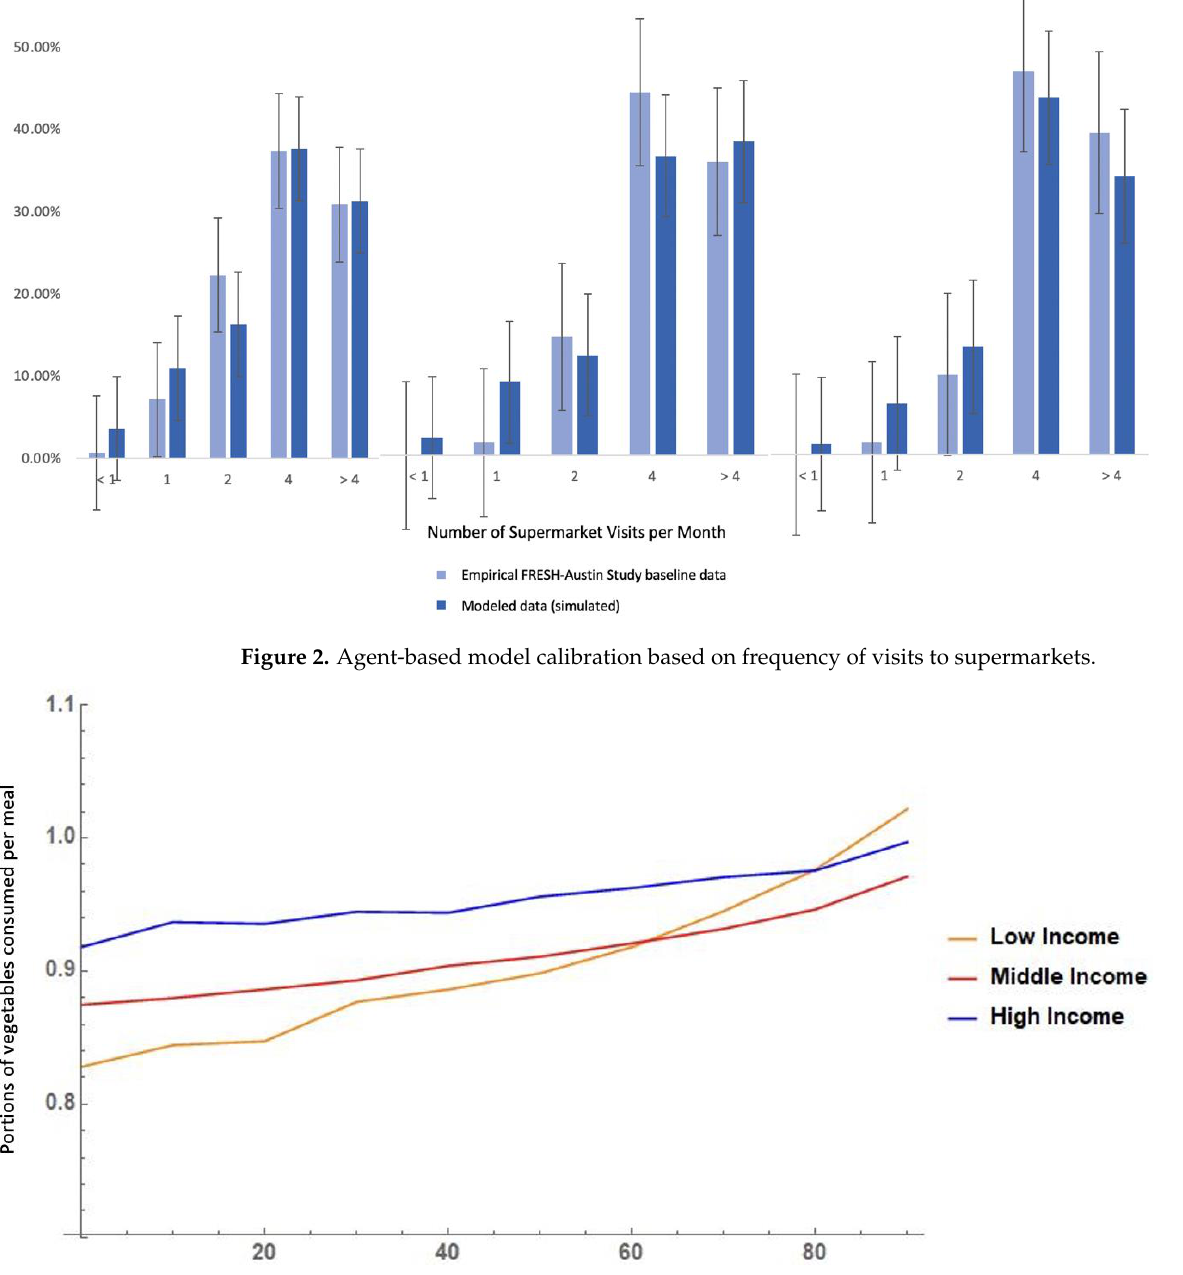
Figure 4. Agent-based model simulation results for Fresh for Less policy expansion scenarios. Relative to the business-as-usual scenario (baseline), expanding geographic access from 7 to 30 available mobile markets in low-income areas was expected to yield an extra 0.06 portions of vegetables consumed per meal. This would account to 0.18 added portions of vegetables per day among low-income community members. An equivalent increase in vegetable intake among low- income residents was predicted in the “economic access only” expansion scenario, if all existing mobile markets or farm stands were to offer a 70% discount for vegetables. Under the same policy expansion scenario, it was predicted that